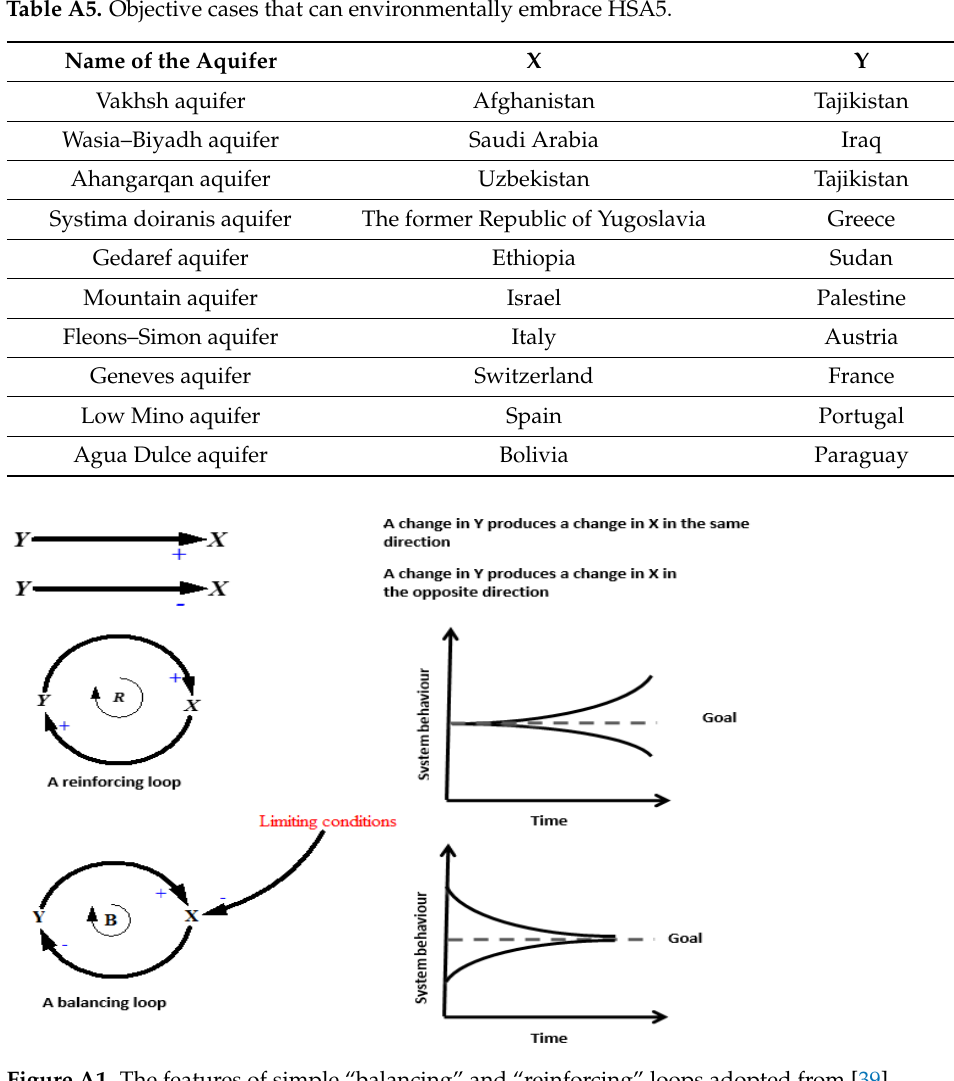
Table A4. Objective cases that can environmentally embrace HSA4.